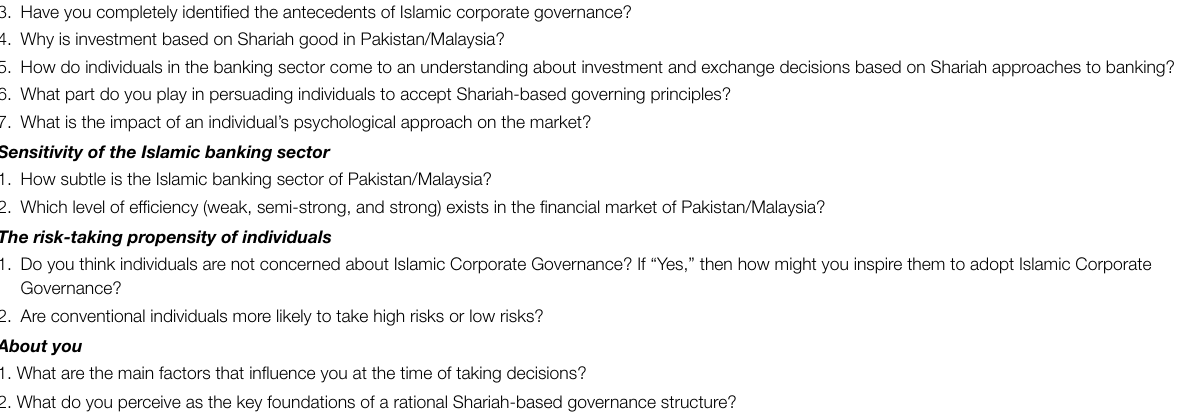
Table 2 : Job Roles. This table speculates that whole contributors have excessive data concerning Shariah-based speculation and tradeoff practices and processes, and the wide-ranging ups and downs of the market.